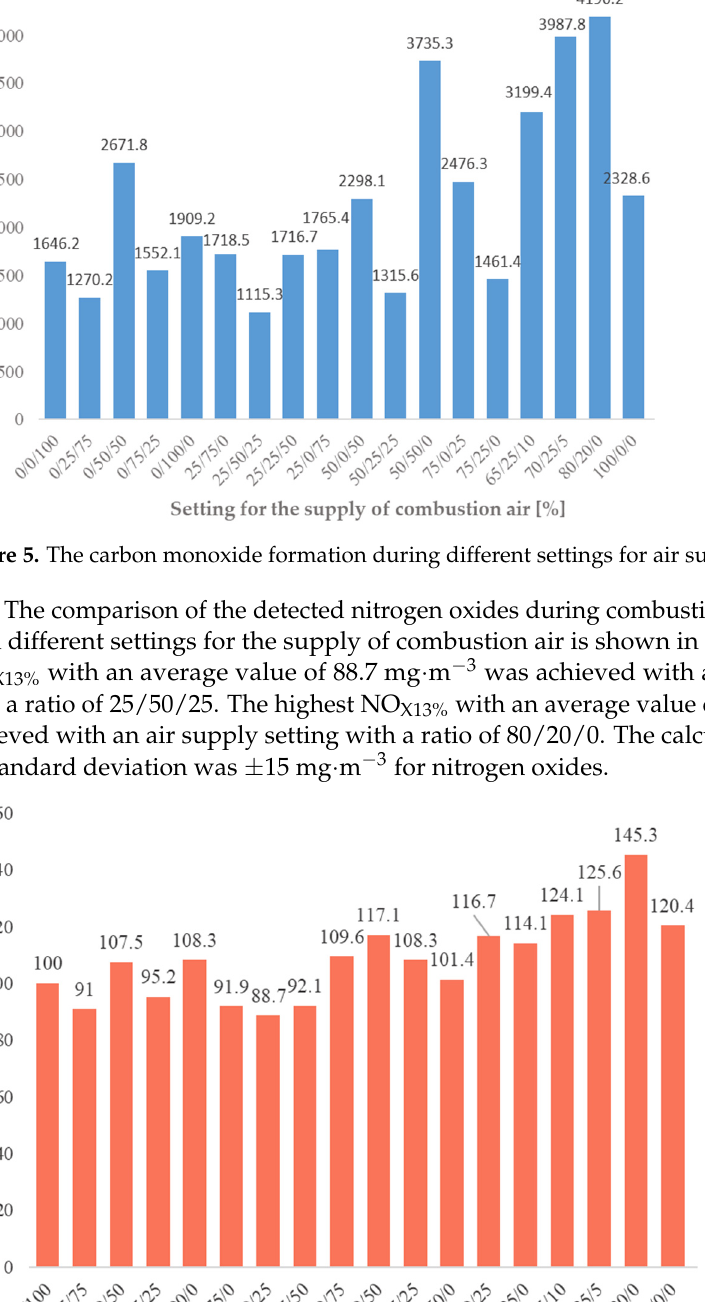
Figure 4. The heat output comparison during different settings for air supply.